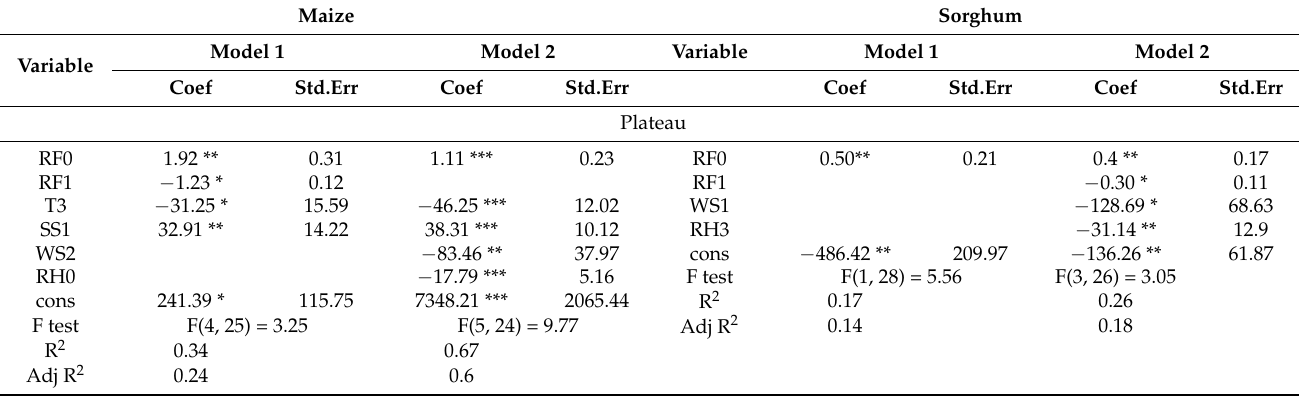
Table 5. Stepwise regression results for the weather- yield with weather factors on the maize and sorghum growth